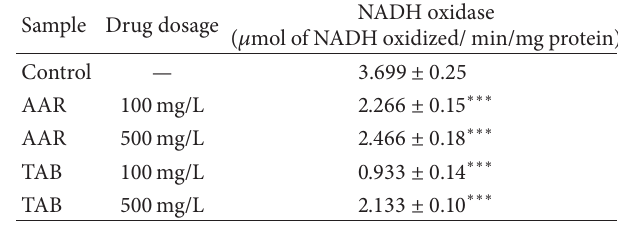
T 1: Preliminary phytochemical screening of hydroalcoholic extract AAR and